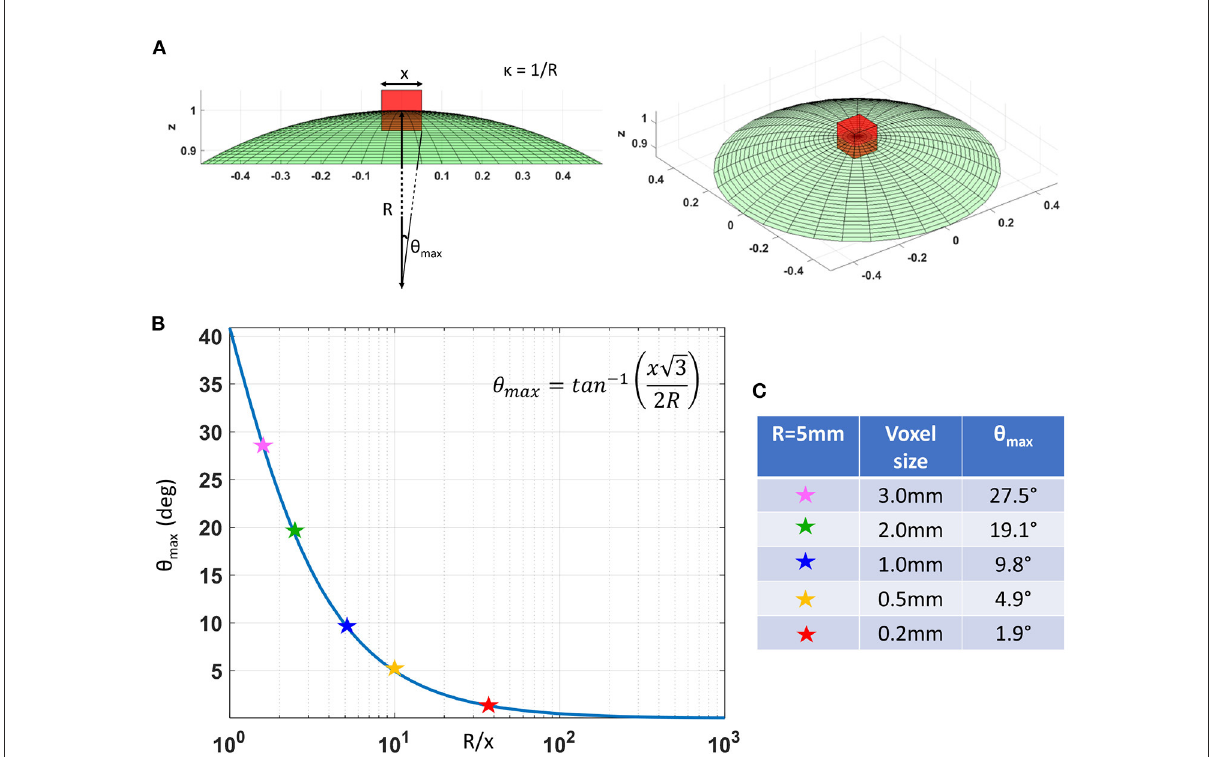
FIGURE1 (A) As we decrease the voxel size, x , relative to the radius of curvature of the tissue (e.g., due to cortical folding), R , the intravoxel orientational variance of the continuously varying microstructural reference frame also decreases. For a voxel with an arbitrary orientation relative to the θ max . (B) The value of θ max decreases rapidly underlying microstructure, the range of intravoxel orientational variation due to tissue curvature is ± at low spatial resolutions, R / x , but changes very slowly at higher spatial resolutions, R / x . (C) A quantitative comparison of θ max at different voxel sizes assuming a cortical radius of curvature R 5 mm shows the significant reduction in intravoxel orientational variance due to the effects of = anatomical curvature at high spatial